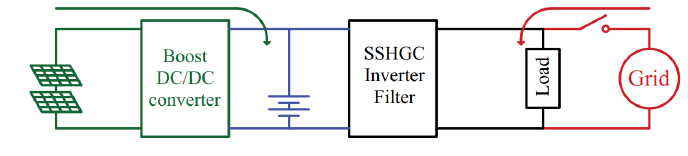
Figure 6. Power operation mode 3.